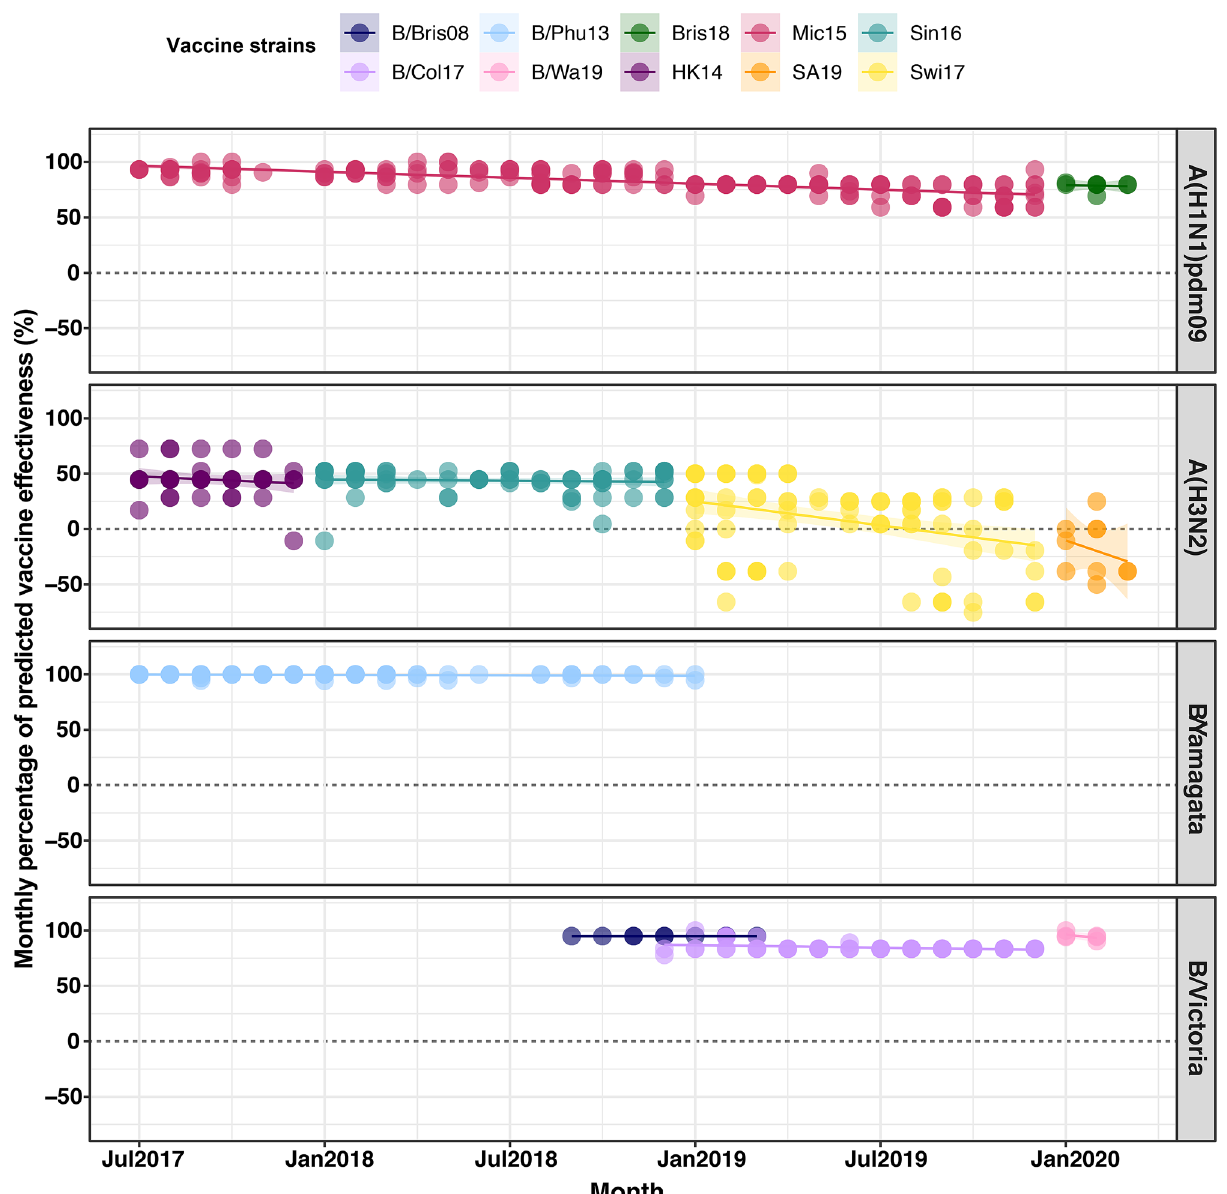
Figure 6. Estimation of the trend of computed antigenic relatedness between July 2017 and March 2020. Computed antigenic relatedness was derived using the P epitope model by comparing vaccine strains and plotted by using R v3.6.0 (https ://www.r-proje ct.org). Circulating A(H1N1)pdm09 viruses were compared with A/ Michigan/45/2015 (Mic15) and B/Brisbane/02/2018 (Bris18). Circulating A(H3N2) viruses were compared with A/Hong Kong/4801/2014 (HK14), A/Singapore/INFIMH-16–0019/2016 (Sin16), A/Switzerland/8060/2017 (Swi17) and A/South Australia/34/2019 (SA19). The circulating B/Yamagata-like lineage was compared with B/Phuket/3073/2013 (B/Phu13) and the B/Victoria-like lineage was compared with B/Brisbane/60/2008 (B/ Bris08), B/Colorado/06/2017 (B/Col17), B/Washington/02/2019 (B/Wa19) with the corresponding number of deletions. The colored circles of each panel represent individual computed antigenic relatedness against the vaccine strain in that